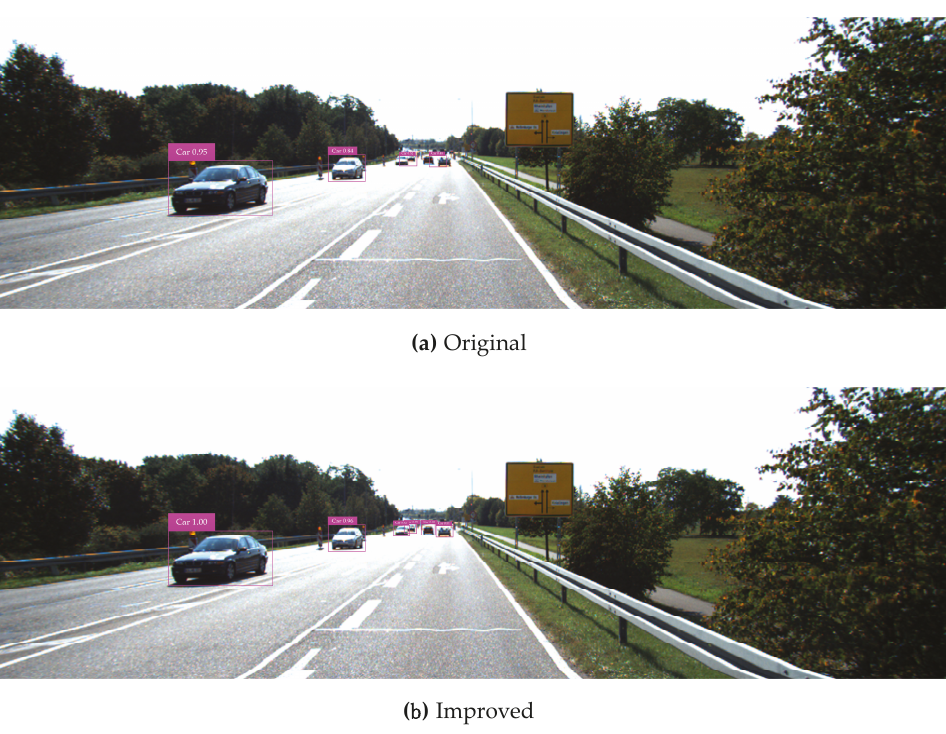
Figure 9. Vehicle detection test results for multi-scale objects based on the original and improved SSD.